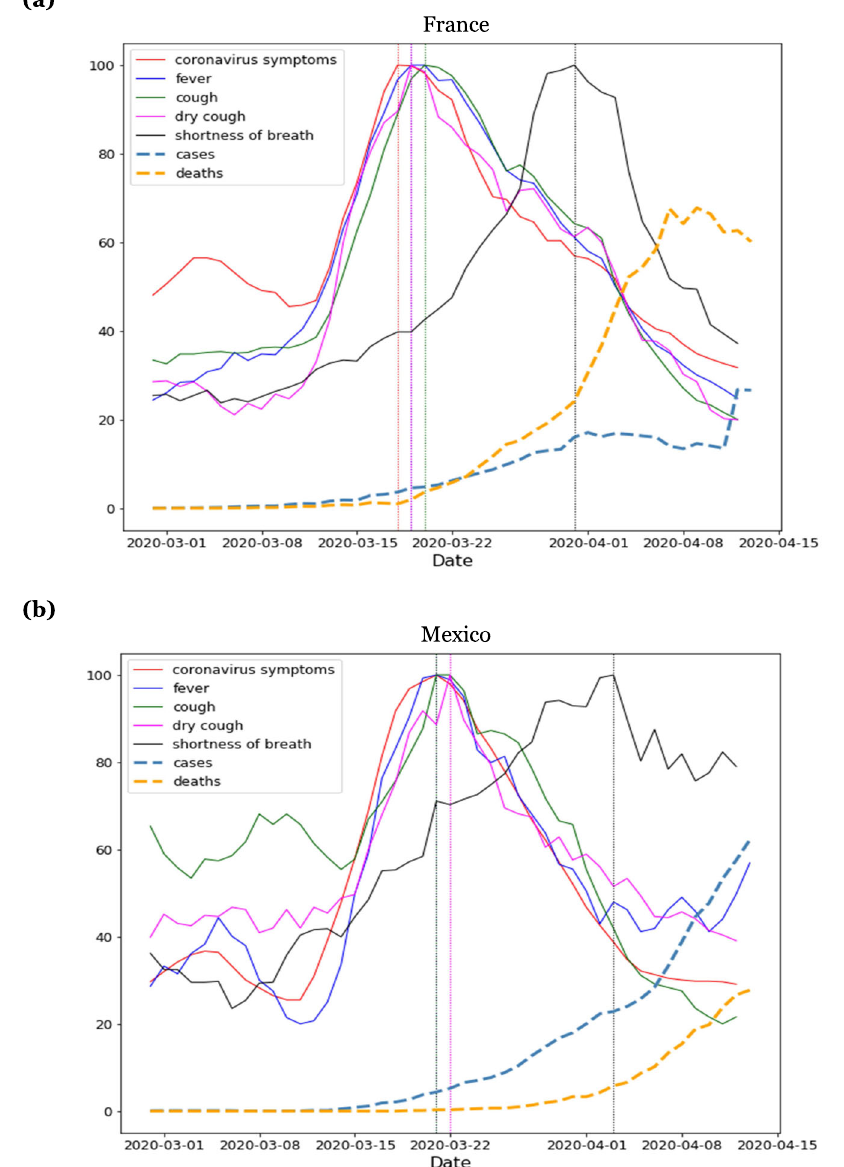
Fig. 3 Clinical course of symptoms in individual countries. Clinical Course of COVID-19 symptoms in ( a ) France and ( b ) Mexico. Search volumes for the terms “ coronavirus symptoms ” , “ fever ” , “ cough ” , “ dry cough ” , and “ shortness of breath ” (black) are shown alongside COVID-19 cases (dashed cyan line) and deaths (dashed orange line). Initial symptoms appear clustered together in time, with searches for shortness of breath appearing a few days later. To highlight the temporal relationships between curves, the magnitude of each curve was independently normalized to fi t the vertical dimensions of the